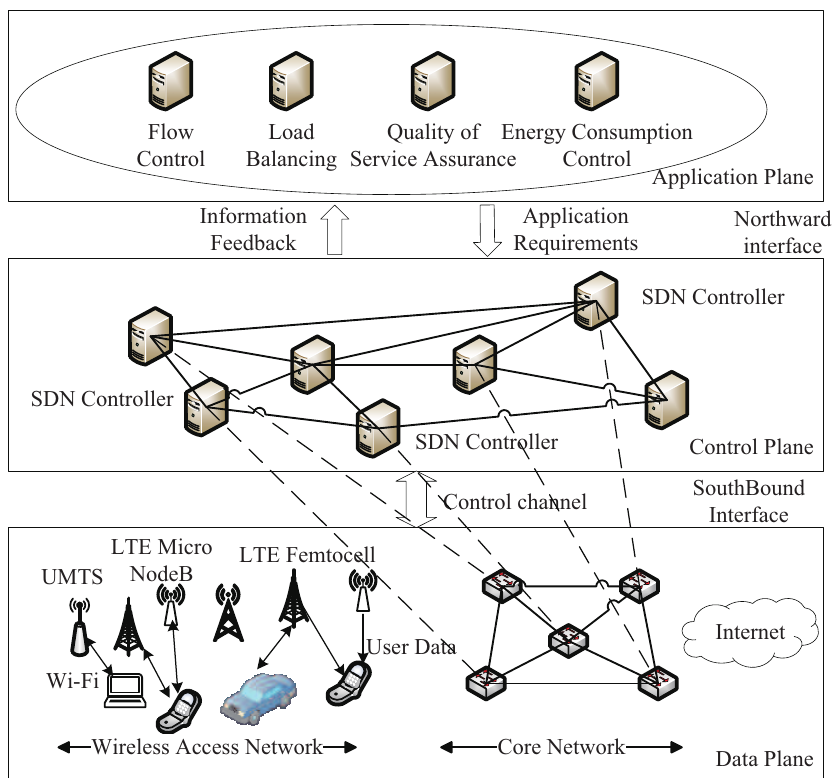
Figure 2. SDN-based